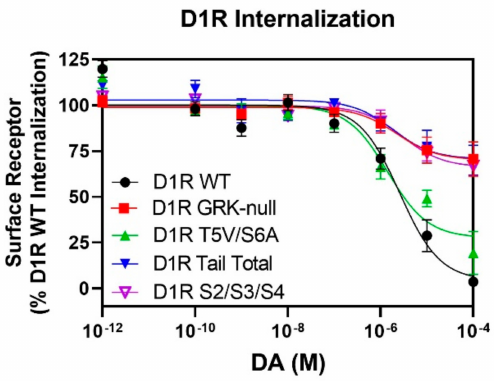
Figure 9. BRET assays of dopamine-induced D1R internalization indicate that the S2/S3/S4 cluster of serine residues in the ICL3 is necessary for efficient receptor internalization. Lyn BRET